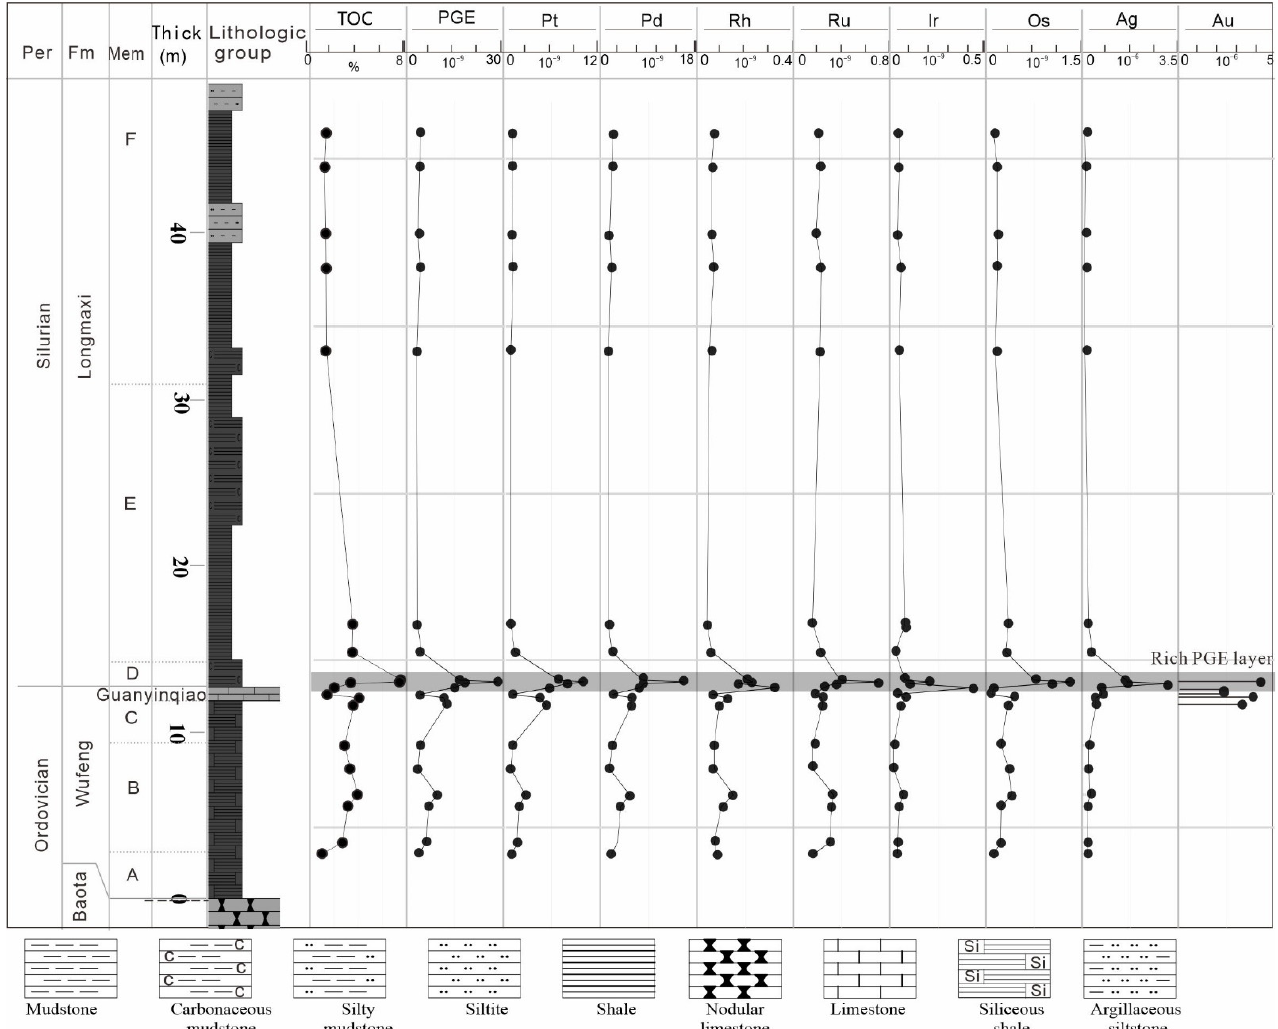
Figure 5. Characteristics of PGEs in CN outcrop.